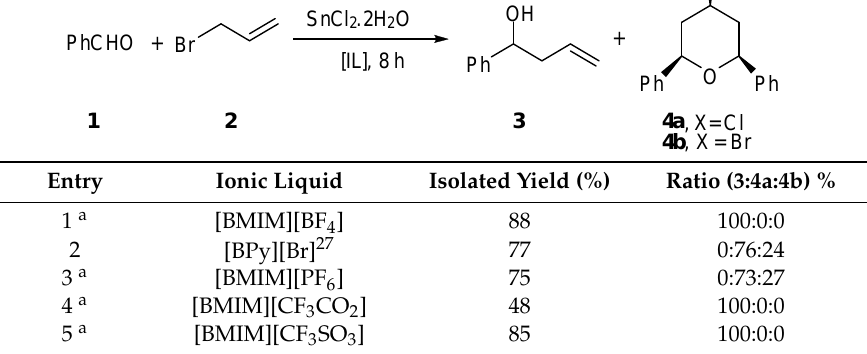
Table 2. Reaction of benzaldehyde (1) with allyl bromide (2) in different ionic liquids.